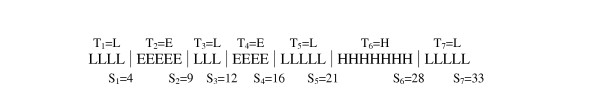
The secondary structure sequence and its representation by structural segments.